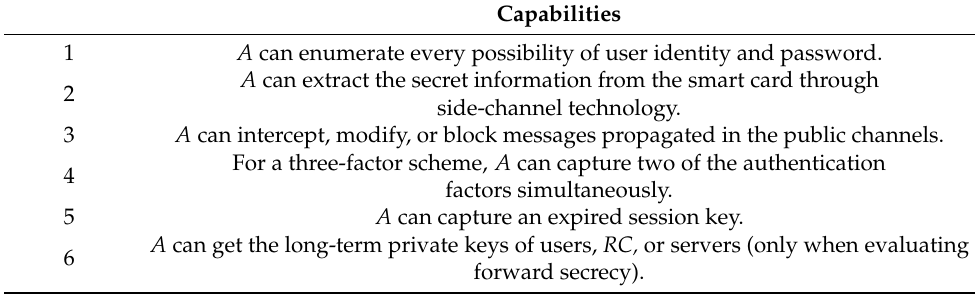
Table 1. Attackers’